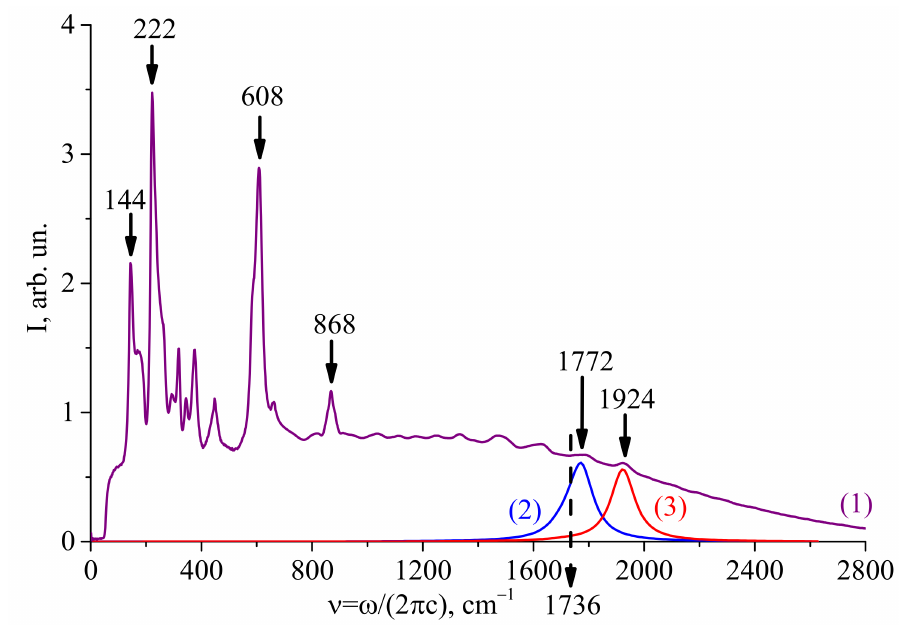
Figure 5. Comparison of the spectral Raman intensity of the LiNb 0.6 Ta 0.4 O 3 ceramic solid solution (curve 1) in the overtone region with the calculated ρ 2 ( ν ) dependences (2) and